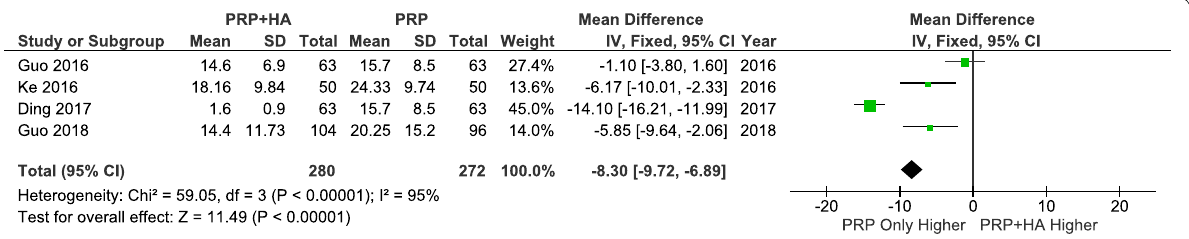
Fig. 13 Showing the Forest plot comparing the WOMAC function scores between PRP